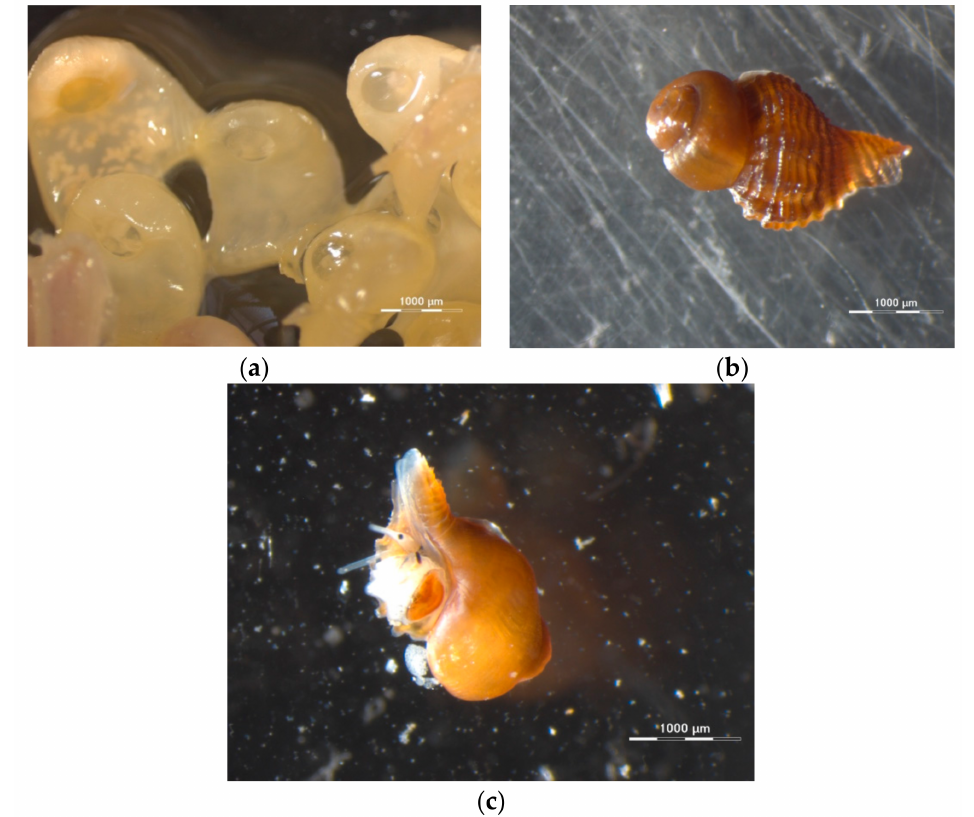
Figure 1. ( a ) Egg capsules ( × 8 magnification) and ( b , c ) living juveniles of Hexaplex trunculus ( × 25 magnification) using a stereoscope (Zeiss